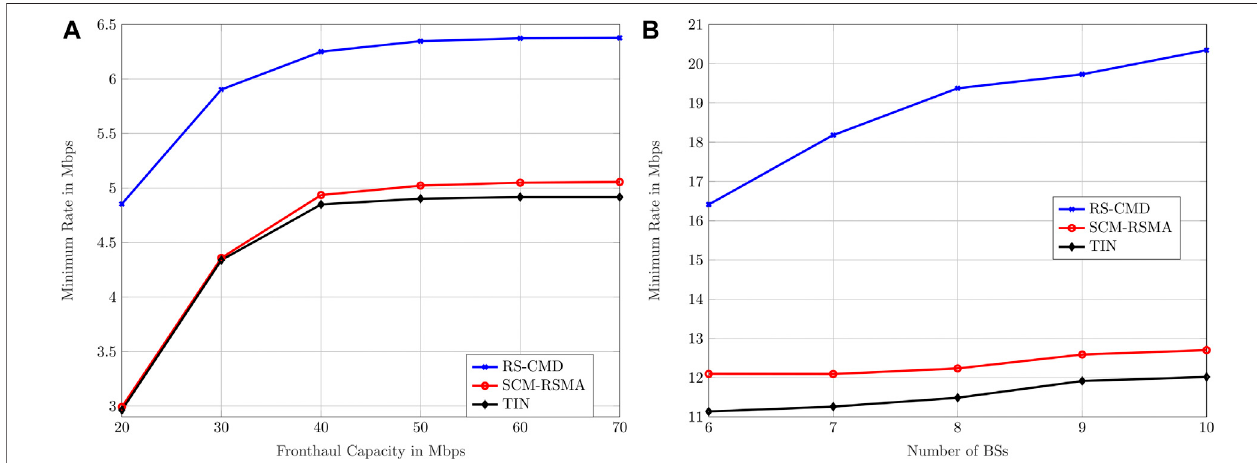
FIGURE3| MMFrateasafunctionofdifferentparameters.WeconsidertheproposedRS-CMDscheme,thereferenceSCM-RSMA,andTIN. (A) showstheMMF rate vs. fronthaul capacity for statistical CSIT. (B) shows the MMF rate vs. number of BSs for full CSIT.